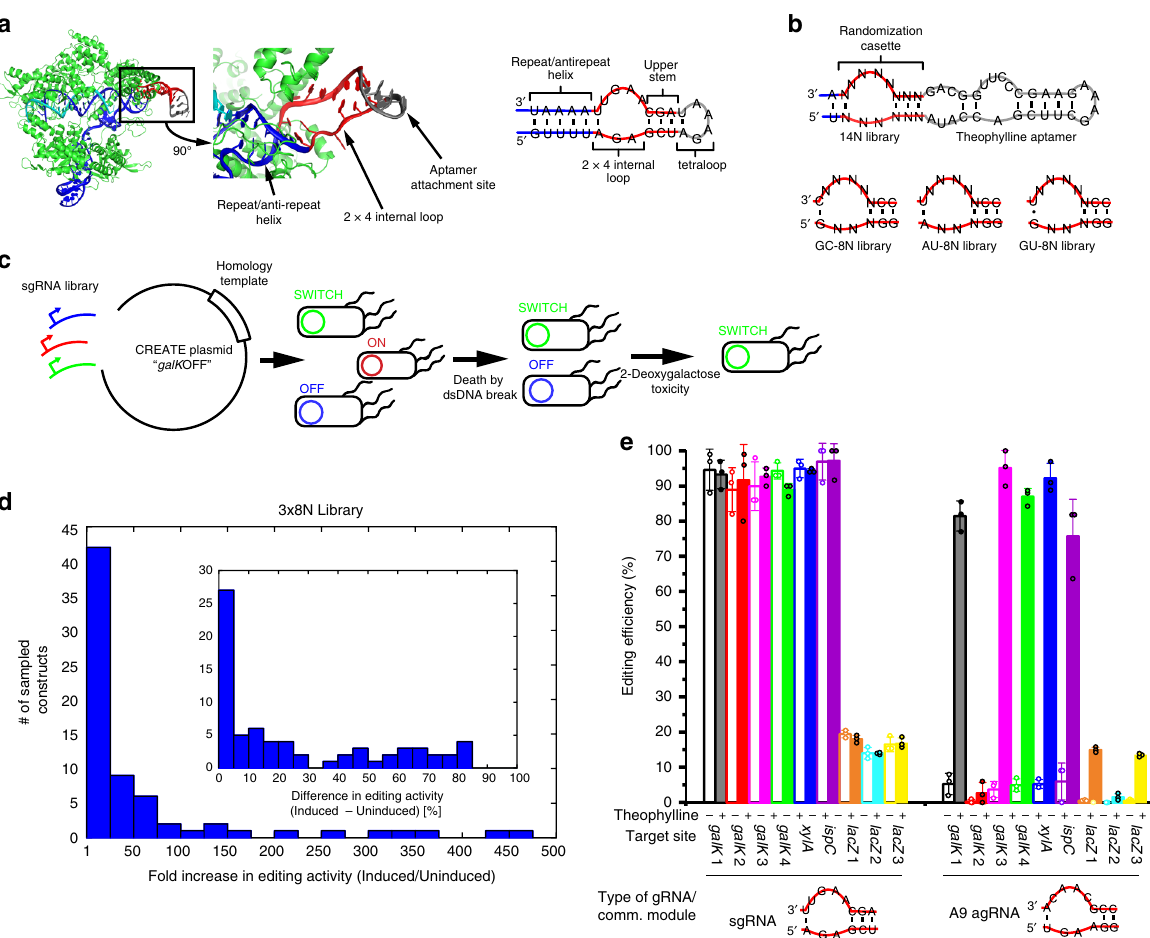
Fig. 1 Design, selection and screening of agRNA libraries. a The theophylline aptamer is inserted into the sgRNA at the site of the tetraloop (gray) used to fuse the guide and tracrRNAs (blue and red). b The 2 × 4 internal loop and fl anking helices was randomized to yield agRNA libraries. c Switchable constructs are enriched in the two steps of the galK survival selection. d Overview of constructs that were sampled from the enriched plasmid library after the galK survival selection. Editing was induced with 1 mM theophylline. Left panel, agRNAs are binned according to the difference in editing ef fi ciency in an induced and uninduced population. Inset panel, agRNAs are binned according to the fold increase in editing ef fi ciency upon induction. e Inducible gene editing was tested at nine different genomic sites. n = 3 biological replicates. (Full circles: 1 mM theophylline; empty circles: no theophylline. Bars indicate average value; error bars indicate standard deviation.) Source data are provided as a Source Data fi